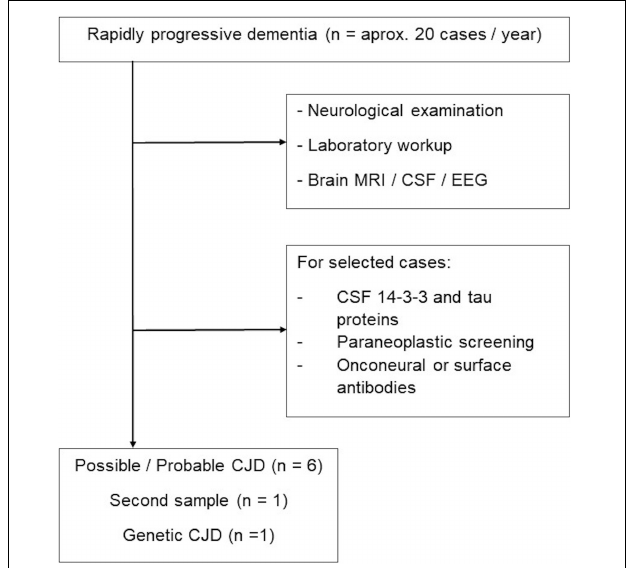
FIGURE 1 | Flowchart of samples included for RT-QuIC